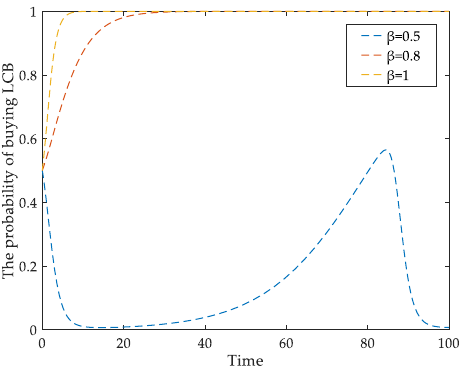
Figure 6. The impact of β on homebuyers’ behavioral evolution.